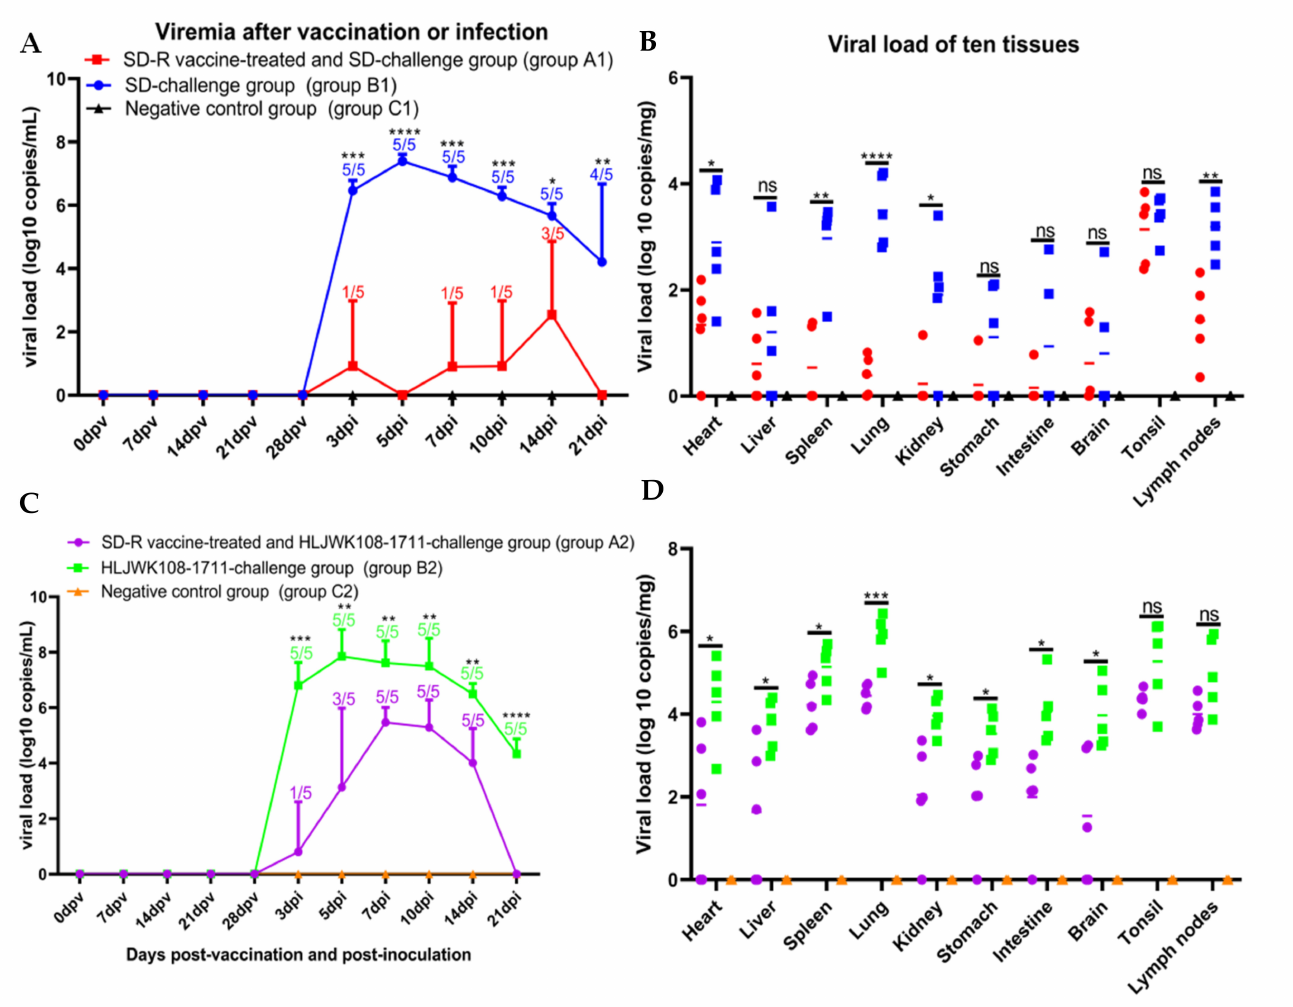
Figure 6. Viremia and viral loads in ten tissues after SD-R immunization and challenge with parental virus SD (( A ) and ( B )) and NADC30-like PRRSV HLJWK108-1711 (( C ) and ( D )). PRRSV viral RNA in sera and tissues were measured by qPCR. The groups A1, B1, and C1 are labelled with red, blue, and black, respectively. The groups A2, B2, and C2 are labelled with purple, green, and orange, respectively. An asterisk (*) indicates a significant difference between the group A1 and B1 or the group A2 and B2 (ns, p > 0.5; *, p < 0.05; **, p < 0.01; ***, p < 0.001; ****, p < 0.0001). The numbers represent the number of piglets with viral loads and the number of piglets in this